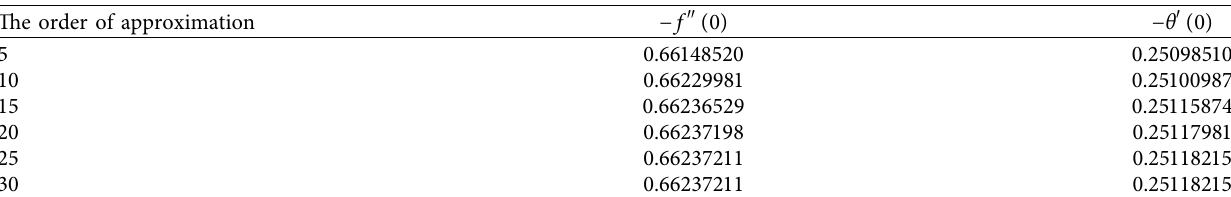
Table 3: The order of approximation ( N ) vs. the skin friction − f ″ ( 0 ) and the Nusselt number − θ ′ ( 0 ) when β � 0 . 7 ,M � 1 .